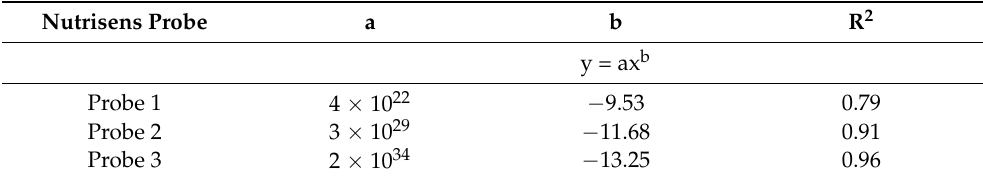
Table 4. Fitting and determination coefficient for the Nutrisens probes when increasing the nitrate concentration in sand at 35% volumetric soil moisture.